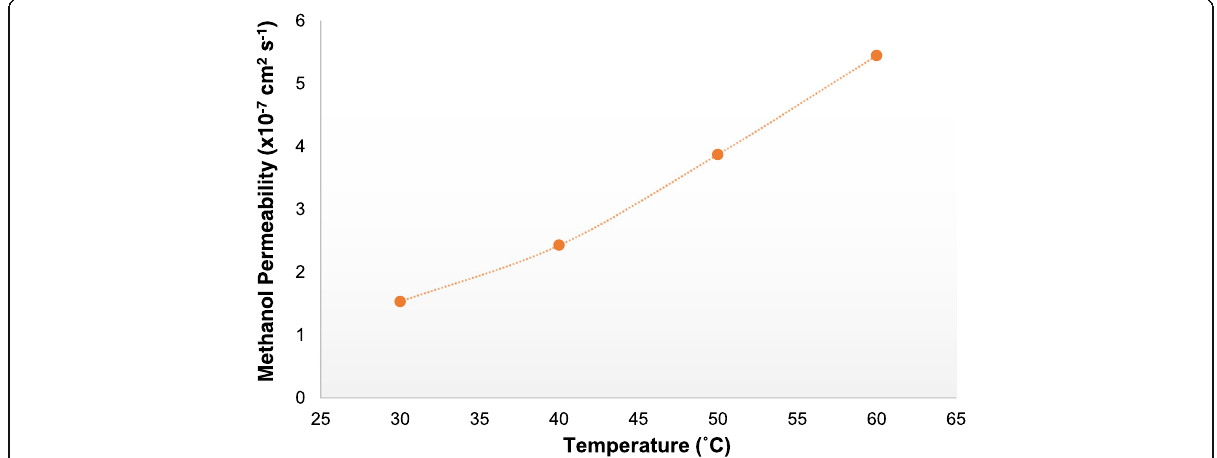
Fig. 12 Methanol permeability of membrane SA/SGO6 vs.